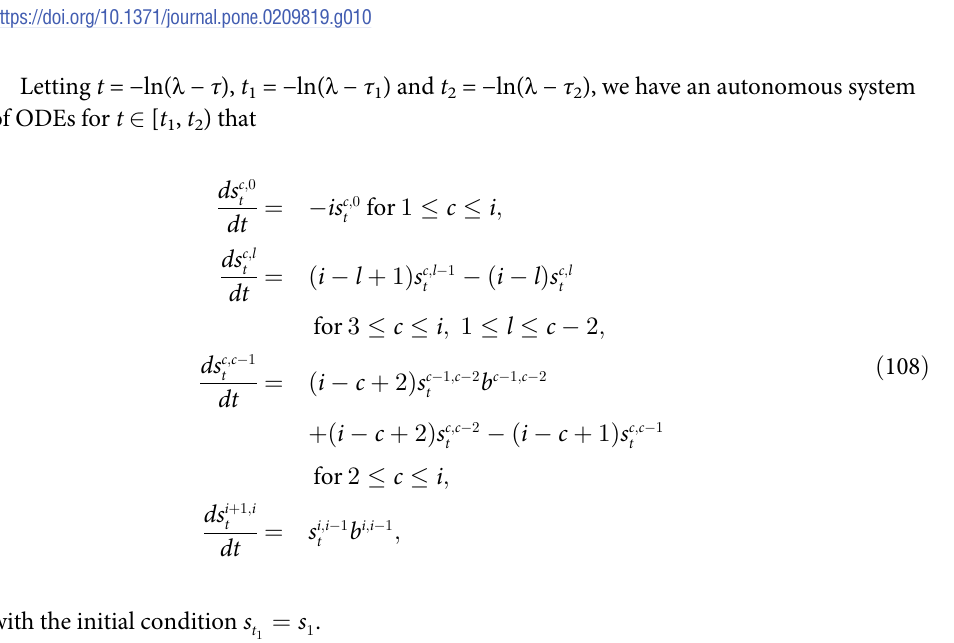
Fig 10. The boxplot and log-log plot of standard deviation and IQR for D / n under alternative